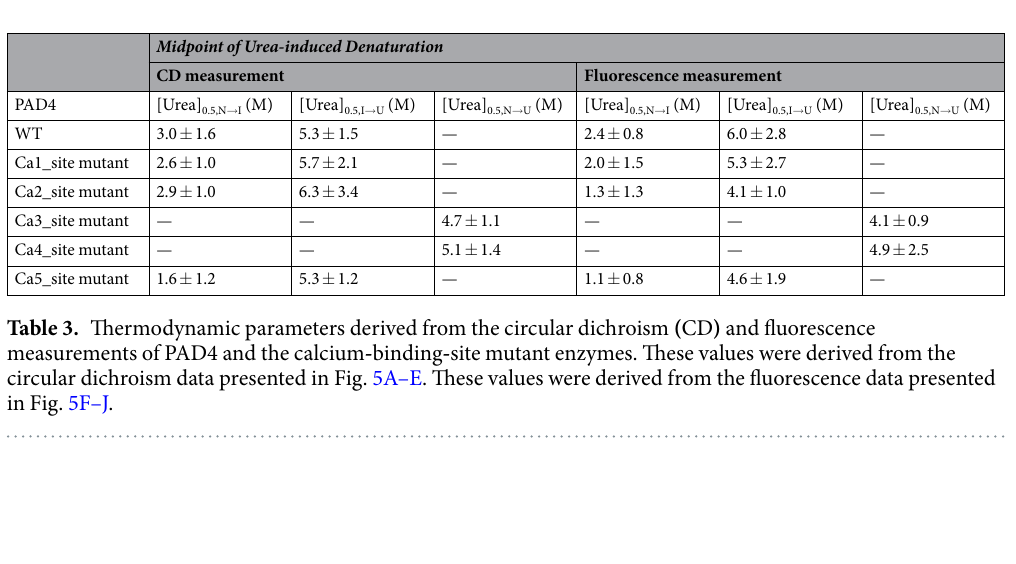
Table 3. Thermodynamic parameters derived from the circular dichroism ( CD ) and fluorescence measurements of PAD4 and the calcium - binding - site mutant enzymes. These values were derived from the circular dichroism data presented in Fig. 5A–E. These values were derived from the fluorescence data presented in Fig. 5F–J.